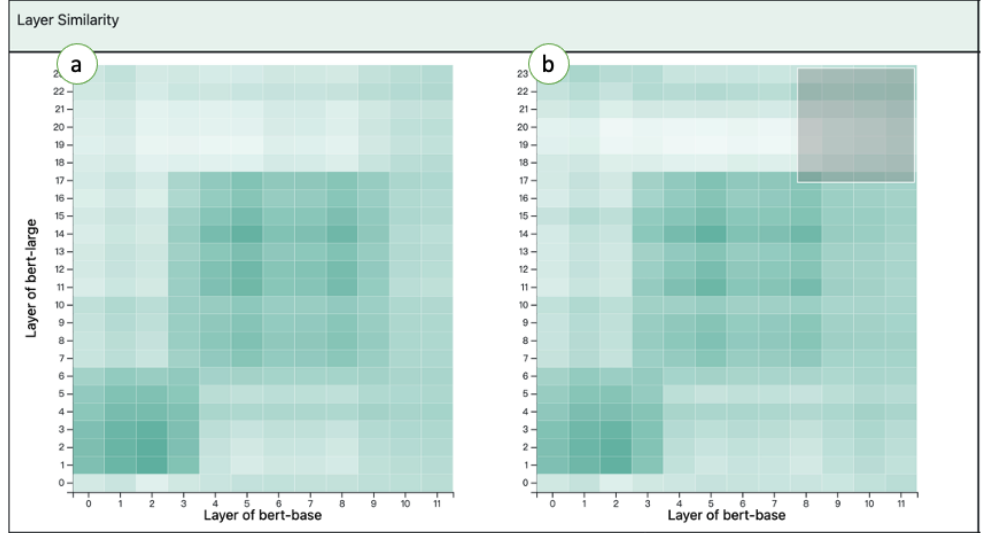
Figure 10. ( a ) is the layer similarity graph calculated from all instances. ( b ) is the filtered layer similarity graph calculated from the instances selected in the scatter